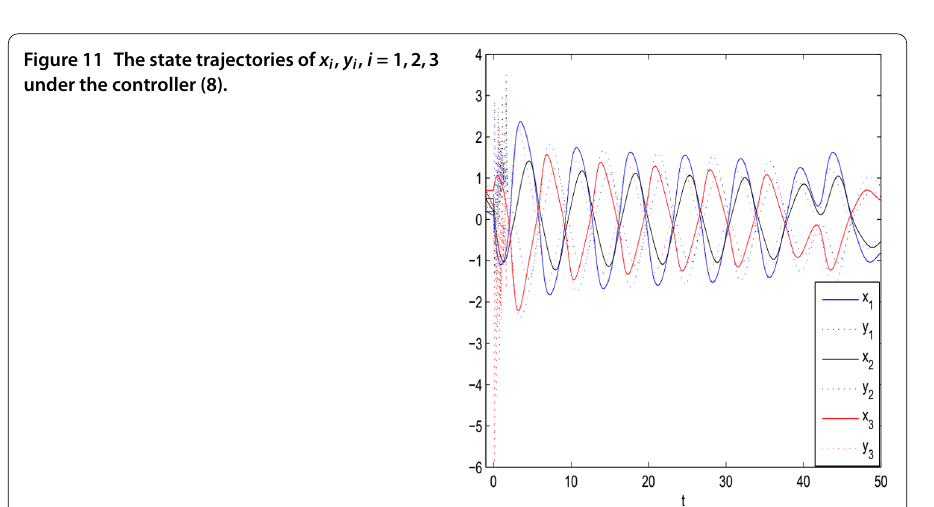
Figure 11 The state trajectories of x i , y i , i = 1,2,3 under the controller